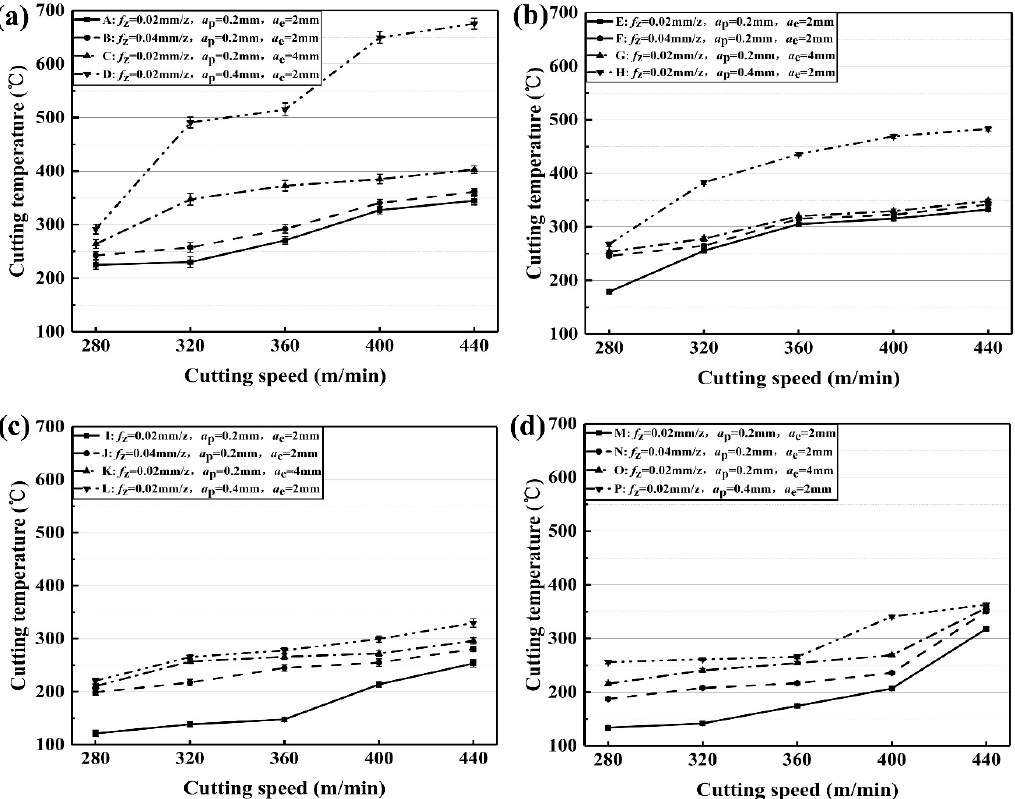
Figure 7. Effect of cutting parameters on cutting temperature, ( a ) TiAlN + TiN coating, ( b ) TiCN + NbC coating, ( c ) TiN/TiCN/TiAlN multi-coating, and ( d ) AlTiN coating.